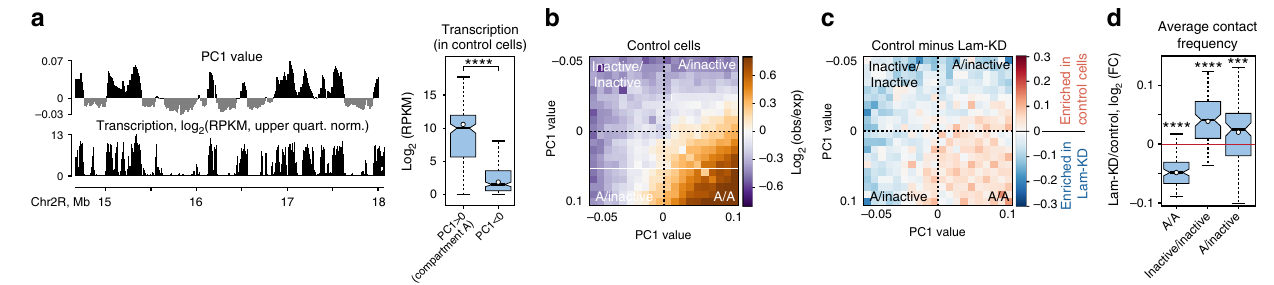
Fig. 4 NL disruption partially impairs spatial segregation of active and inactive chromatin. a A representative screenshot from the UCSC Genome Browser showing correspondence between the positive PC1 values and the transcriptionally active genome regions. Box plots show transcription level in 20-kb genomic bins possessing positive ( n = 4073) and negative ( n = 1868) PC1 values. **** – P < 0.0001 in a Wilcoxon test. b Heatmap showing log 2 values of contact enrichment for the intra-chromosomal contacts in the control cells between genomic regions as a function of their PC1 values (saddle plot). c Subtraction of saddle plots in Lam-KD cells from that in control cells. d Changes of averaged contact frequency between and within active and inactive fractions of chromatin in Lam-KD compared to control cells. **** P < 0.0001, *** P < 0.001 in a Wilcoxon test. See Fig. 1g legend for description of boxplot elements represented on panels ( b ) and ( d